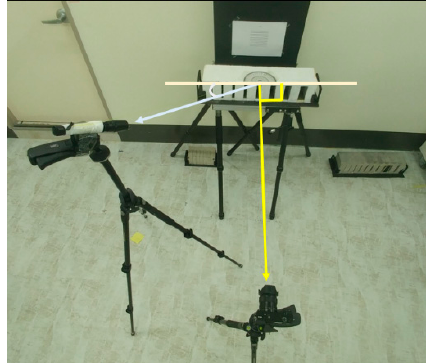
Figure B1. Test setup for analysis of lighting angle and intensity of cracks. Table B1. Changes in brightness in crack depending on light angle and crack width.